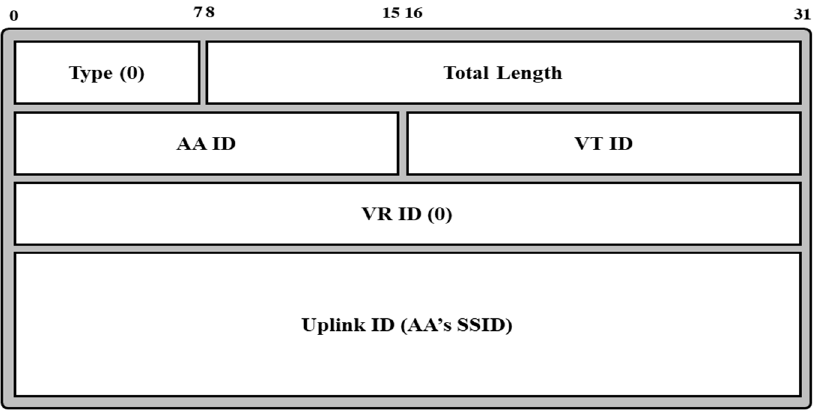
Figure 7. Beacon message. Figure 7. Beacon